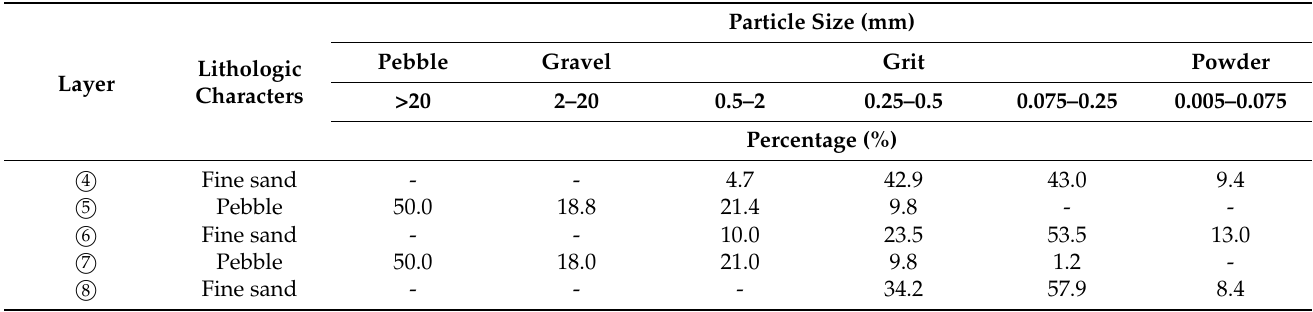
Table 3. Summary of average grain composition of pebble layer and sand